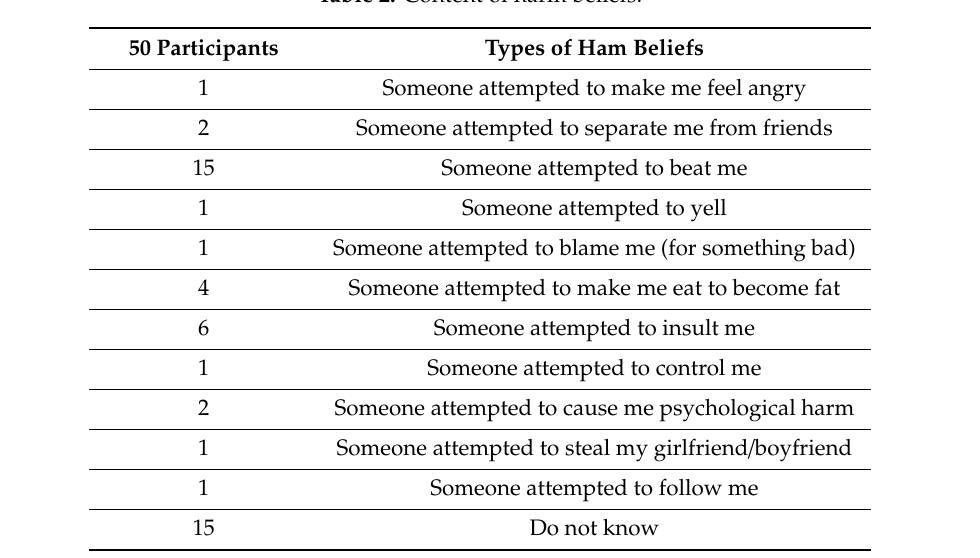
Table 2. Content of harm